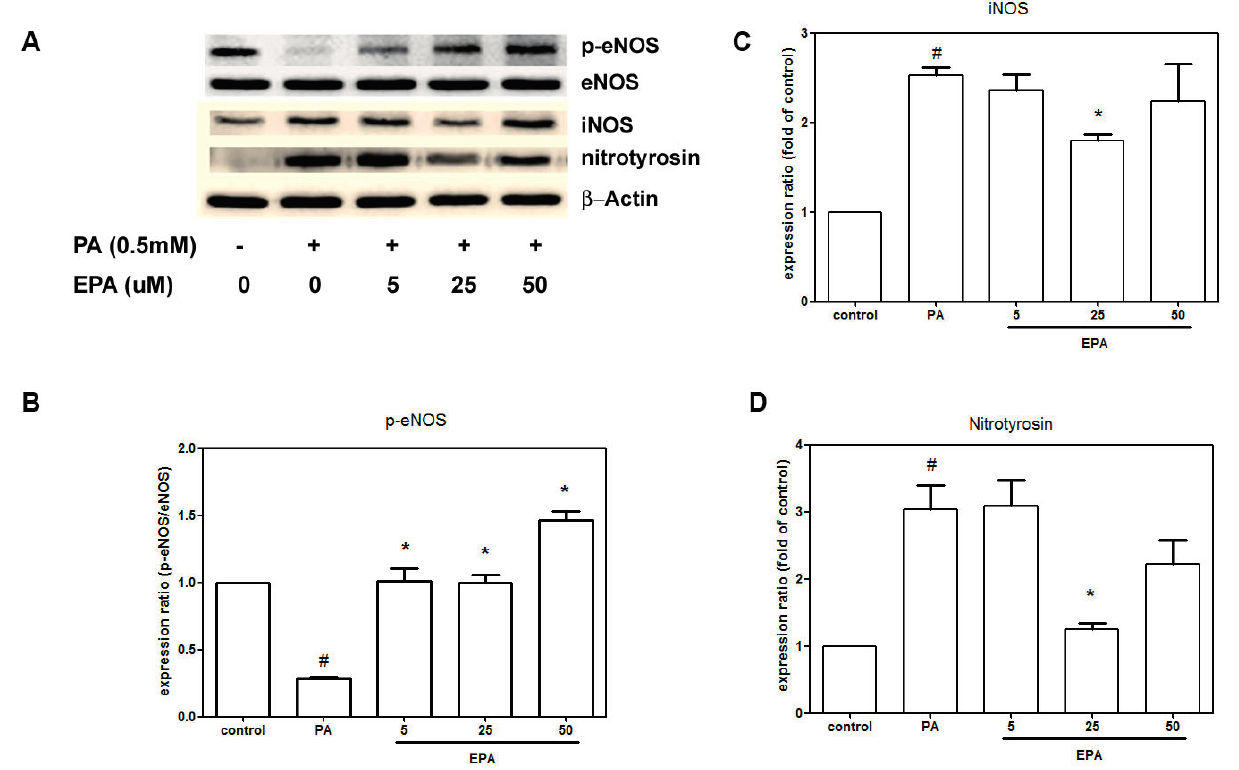
Figure 4. EPA attenuated the PA-induced downregulation of eNOS and upregulations of iNOS and nitrotyrosine. The HUVECs were pretreated for 2 h with the indicated concentrations of EPA followed by stimulation with PA (0.5 mM) for 18 h in the presence of EPA. The levels of the phosphor-eNOS, eNOS, iNOS and nitrotyrosine proteins were determined by western blot ( A ); The quantifications of the related phospho-eNOS ( B ); iNOS ( C ) and nitrotyrosine ( D ) are shown. The values are presented as the means ± the S.E.s of three independent experiments. # p < 0.05 vs. untreated control; * p < 0.05 vs. PA